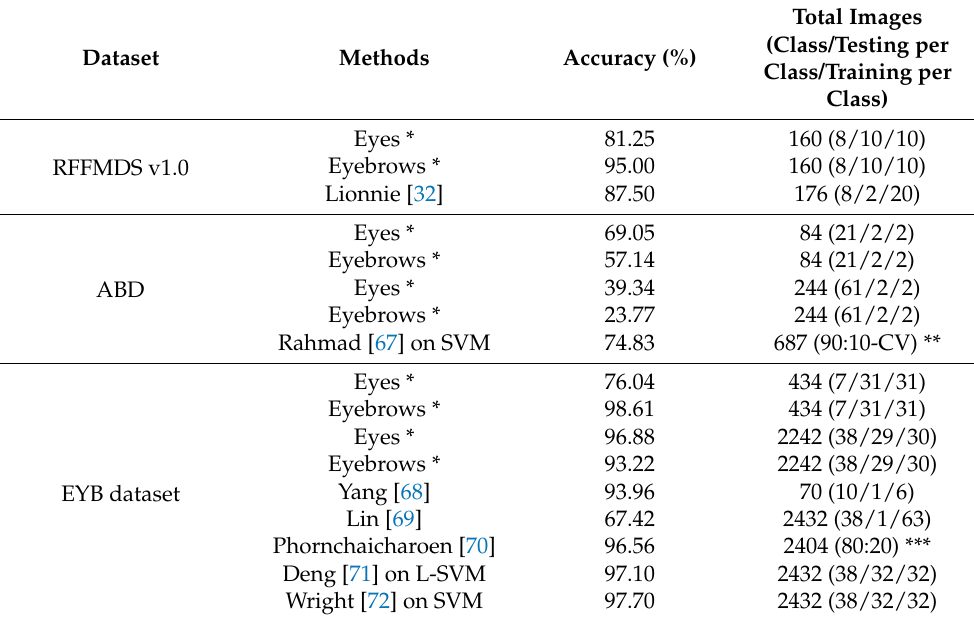
Table 12. Comparison of accuracy (%) results with other methods.